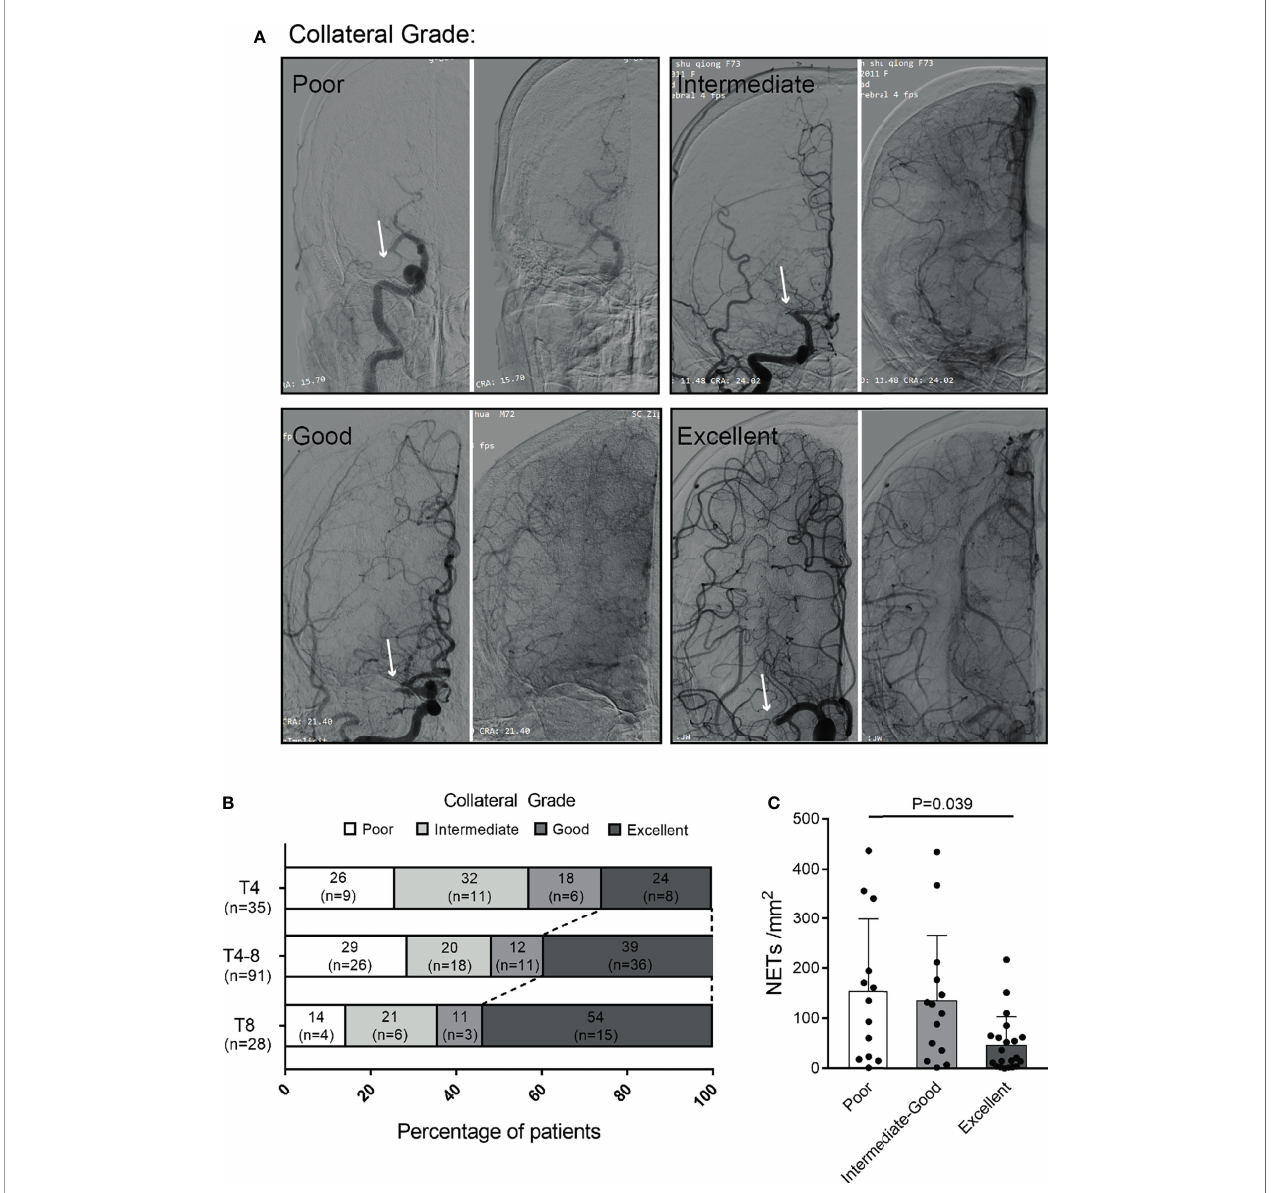
FIGURE 4 | Association of NETs in thrombi with collateral fl ow of patients with ischemic stroke. (A) Examples of collateral fl ow with digital subtraction angiography (DSA)-based collateral grades. All DSA images show proximal middle cerebral artery (MCA) occlusions (arrows). The DSA consists of arterial (left panel) and venous phases (right panel). Poor grade: no collaterals visible or slow collaterals visible only in the late phase. Intermediate grade: rapid collateral fl ow to part of the occluded MCA territory with persistence of some of the defect. Good grade: slow but complete collateral fl ow in the occluded MCA territory. Excellent grade: rapid and complete collateral fl ow in the occluded MCA territory. (B) Distribution of collateral grade in patients with different times to reperfusion. (C) Quanti fi cation of NETs/ mm 2 in the thrombi of patients with poor ( n = 13), intermediate to good ( n = 14), and excellent ( n = 21) collateral fl ows. NETs, neutrophil extracellular